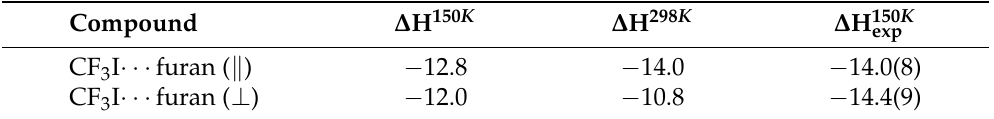
Table 3. Calculated (PBE0-dDsC/QZ4P) and experimental interaction enthalpies (kJ/mol) a for